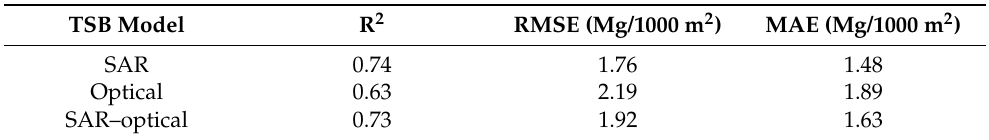
Table 5. Cross-validation metrics derived separately for the models developed using Sentinel-1 and Sentinel-2 data and their